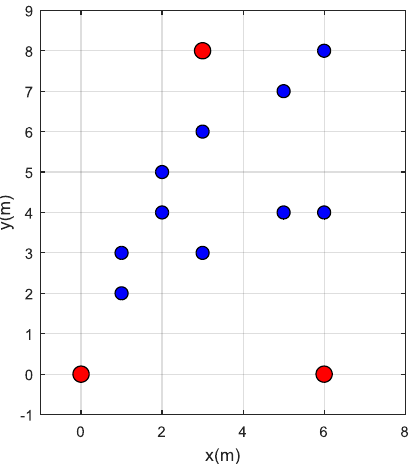
Figure 10. Plot of reference and target nodes for real-time experimental study. Table 5. Coordinates and distances of target nodes.